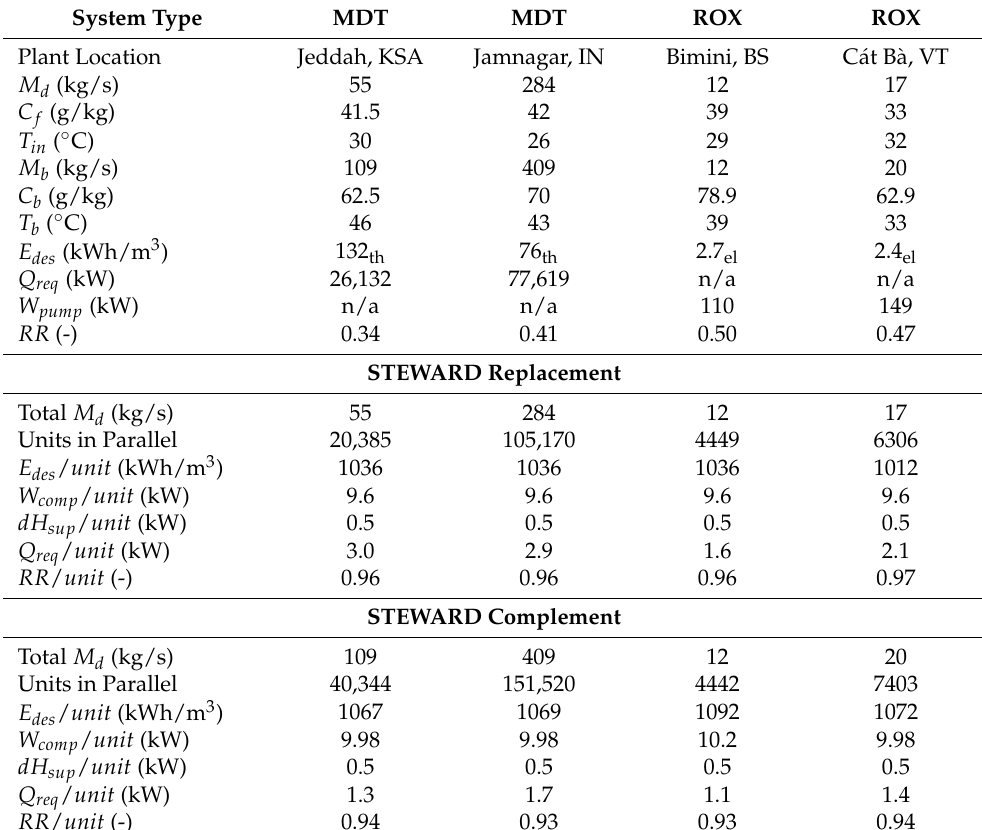
Table 4. STEWARD performance using case-study simulation